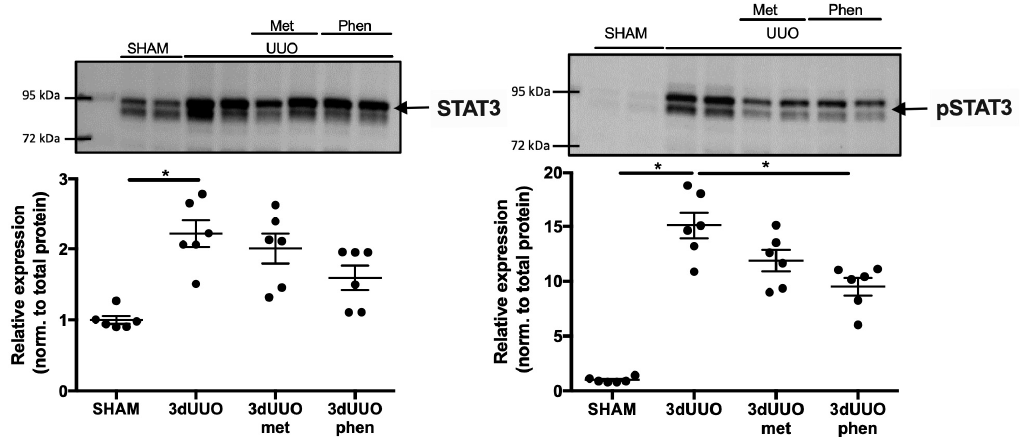
Figure 6. Impact of biguanide treatment on pSTAT3 protein expression following UUO. Protein expression of Signal transducer and activator of transcription 3 (STAT3) and phosphorylated STAT3 (pSTAT3) in response to UUO and biguanide treatment normalized to total protein. n = 6 for each group. Each bar represents the mean ± SEM. * p < 0.05.